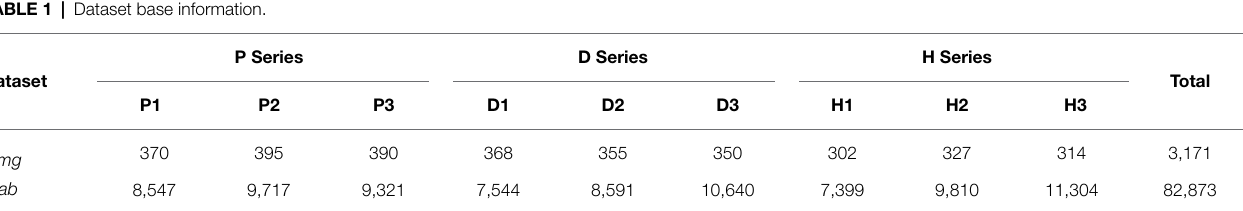
Nimg , total number of images and Nlab , total number of label